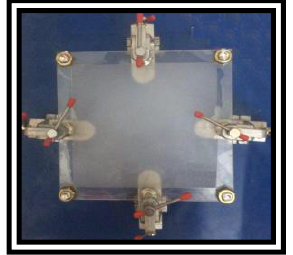
Figure 1: Silicone was poured inside the mold After polymerization, the silicone sheet (15×15 cm) (12) was separated from the mold cavity and was cut (Figure 2) by suitable cutting dies with the help of a custom-made specimen cutting press. capacity (Lezaco, Syria) attached to metal plates; this type of cutting ensures smooth cut surfaces.